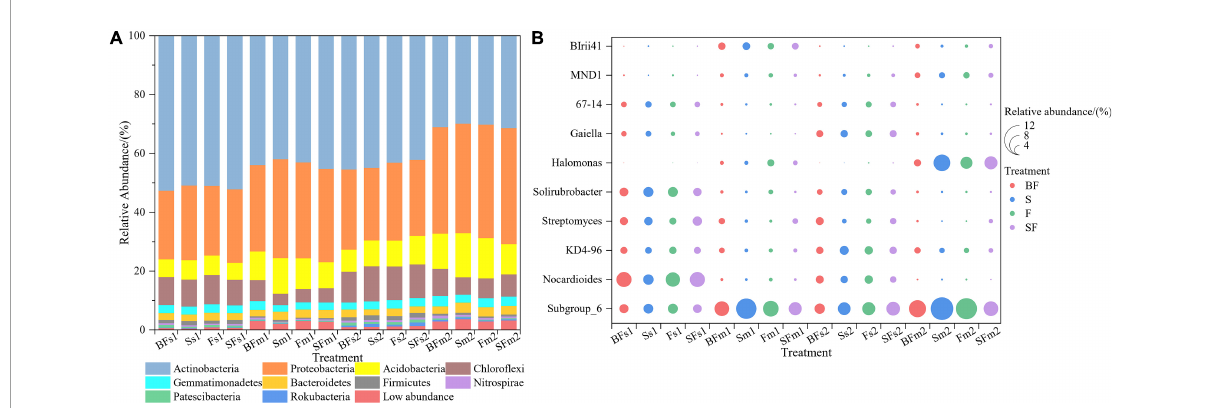
FIGURE4 Relative abundance of taxonomic composition at the phylum (A) and genus (B) level of soil bacterial communities in 0–20 cm under straw and biochar addition. The top 10 relative abundances were shown. BF, S, F, and SF stand for: wheat straw biochar with fertilizer, wheat straw, fertilizer, and wheat straw with fertilizer, respectively. s: Seeding; m: Maturity. 1: 0–10 cm; 2: 10–20 cm.